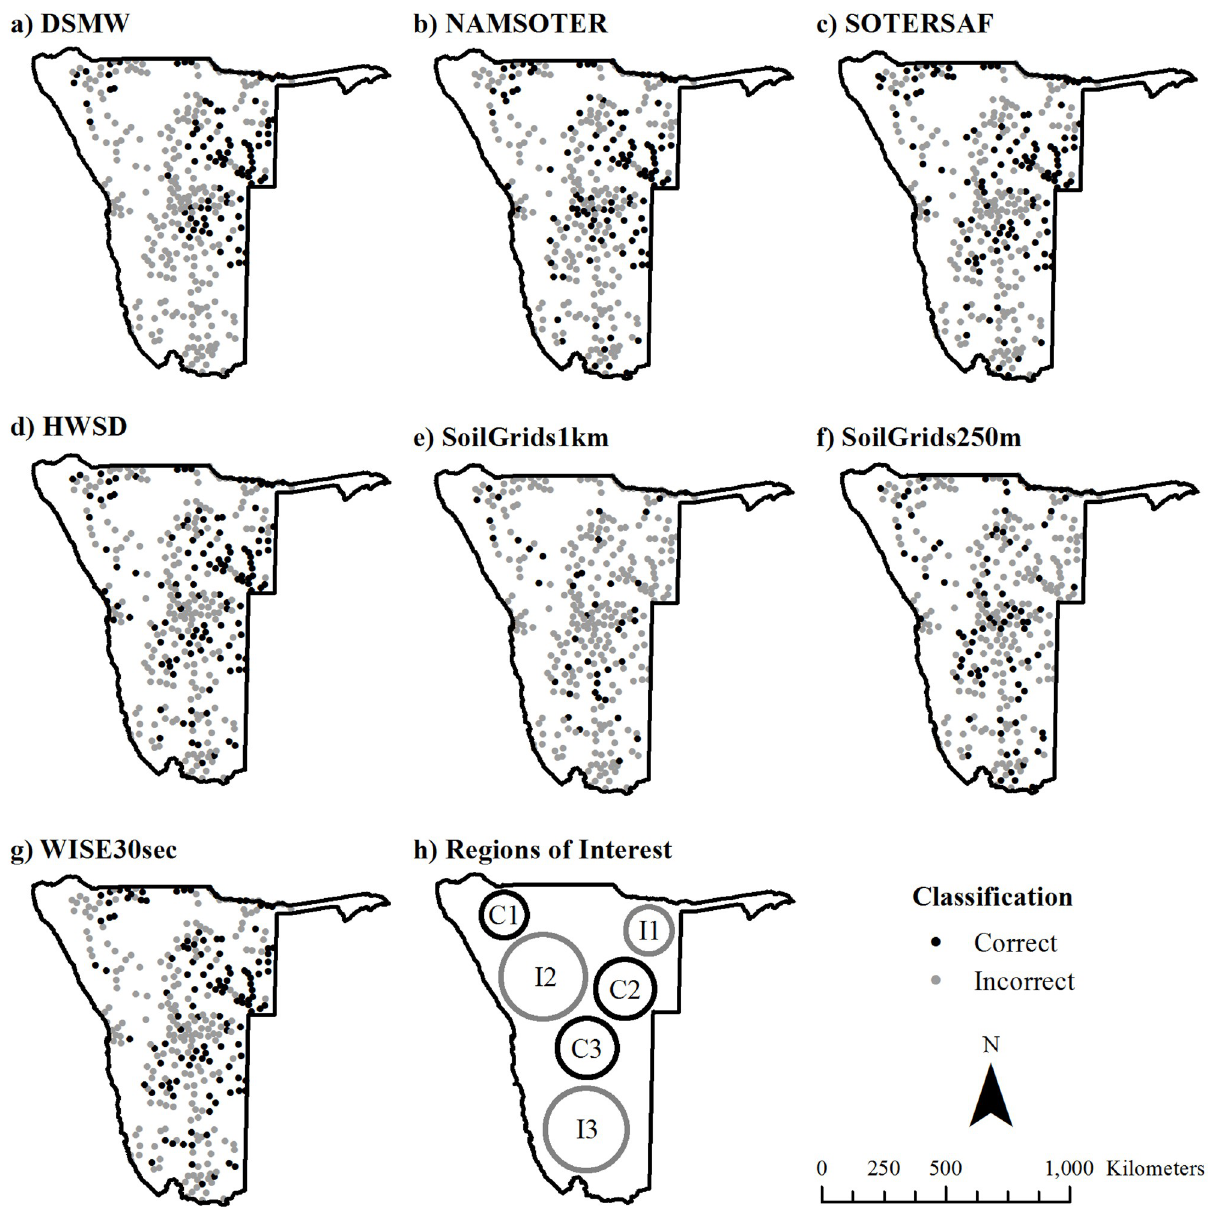
Fig 9. Spatial distribution of correctly and incorrectly classified locations. Panels a-g) show correctly and incorrectly classified locations in: a) DSMW, b) NAMSOTER, c) SOTERSAF, d) HWSD, e) SoilGrids1km, f) SoilGrids250m, and g) WISE30sec. Panel h) shows regions in which locations are often classified correctly (C1, C2, and C3) or incorrectly (I1, I2, and I3). See the text for full names and versions of the map data